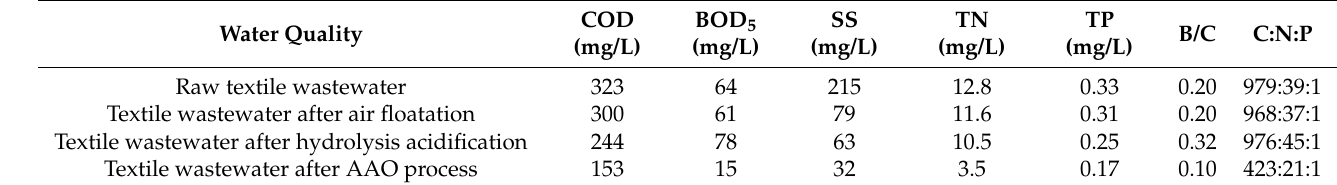
Table 2. Concentrations of pollutants in textile wastewater at different treatment